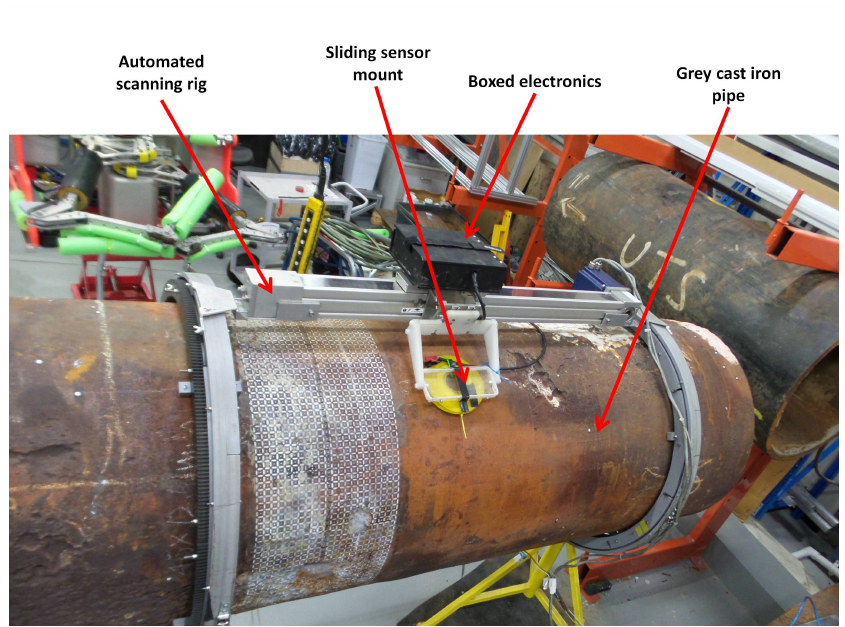
Figure 25. Experimental setup used to scan the grey cast iron pipe section using an automated pipe scanning